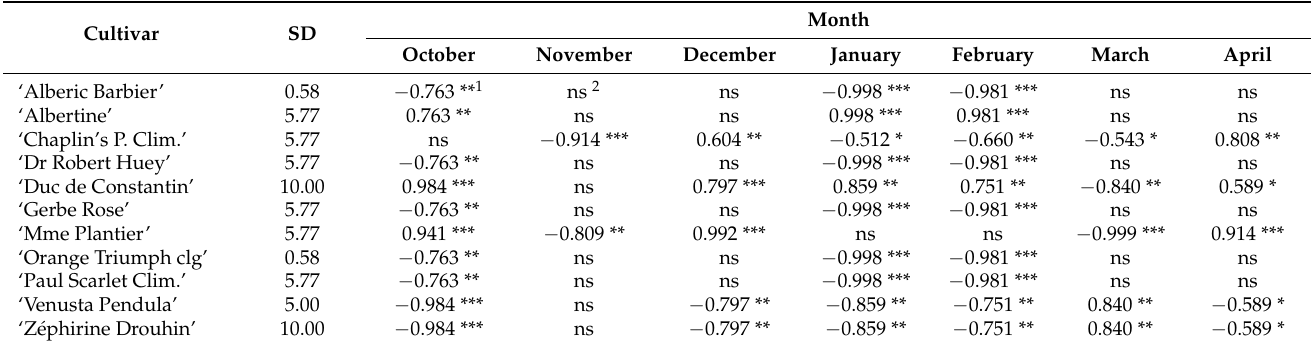
Table 8. The effect of correlations between average monthly air temperature (2005/2006, 2009/2010, and 2015/2016) and period of the first leaf pair unfolding (BBCH 11) in climber roses.